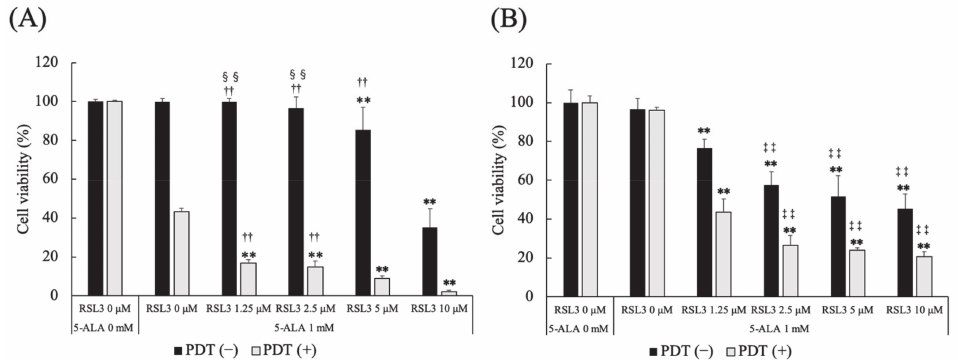
Figure 6. Effect of a glutathione peroxidase 4 (GPx4) inhibitor on 5-ALA-mediated PDT-induced cell death. ( A ) HDC and ( B ) LuBi cells. Results are presented as mean ± standard deviation ( n = 6). Groups were compared using Sidak’s multiple comparison test, ** p < 0.01 vs. RSL3 0 µ M. †† p < 0.01 vs. RSL3 10 µ M. ‡‡ p < 0.01 vs. RSL3 1.25 µ M. §§ p < 0.01 vs. RSL3 5 µ M.